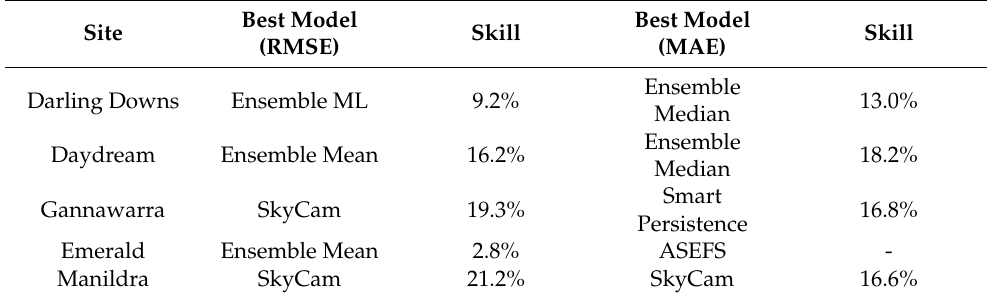
Table 3. Overall forecasting performance compared to